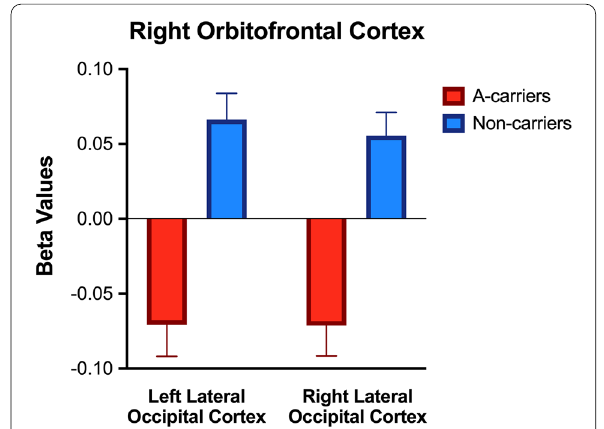
Fig. 2 The main effect of CACNA1C rs100737 on rsFC between the right orbitofrontal cortex seed and bilateral occipital cortex ( p < 0.001). Beta values correspond to Fischer-transformed correlation coefficient values, adjusted for age, sex, and race. Error bars denote standard error of the mean